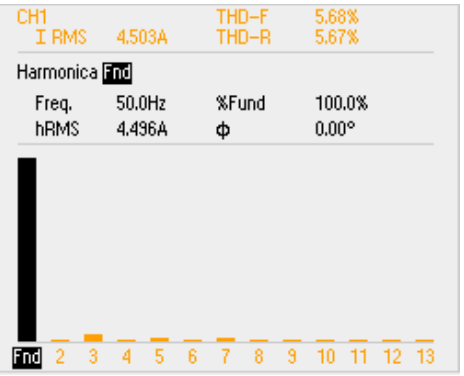
Figure 36. Harmonic spectrum of the grid current in G2V slow battery-charging mode.